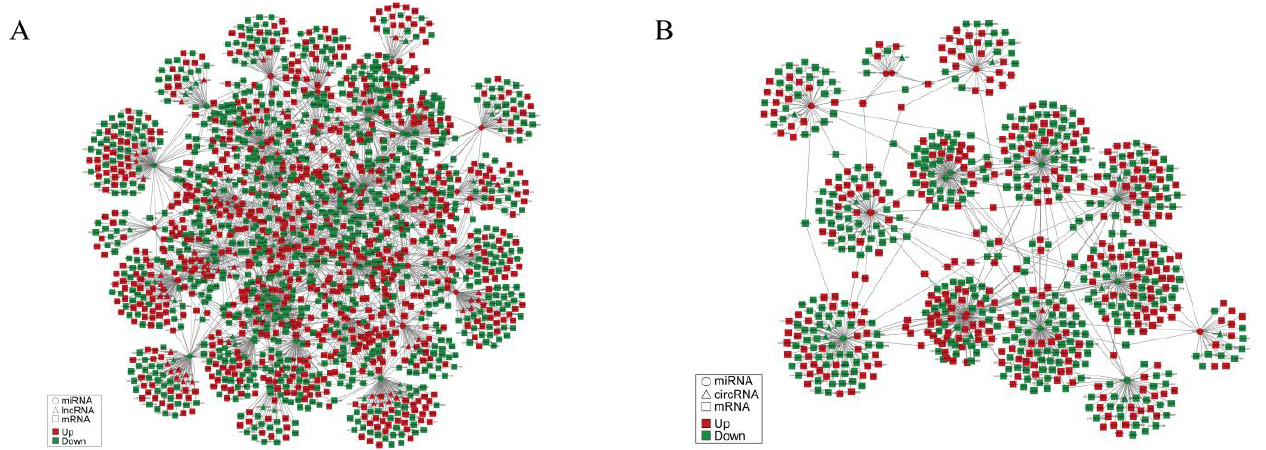
Figure 4. ( A ) The interaction network of lncRNA/circRNA–miRNA–mRNA, and ( B ) the interaction network of